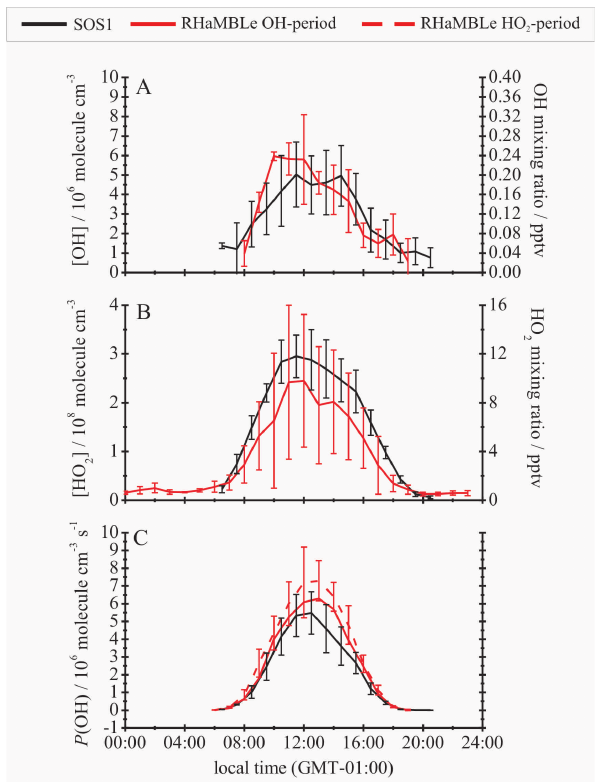
Fig. 9. Plots of the hourly-averaged median diurnal profiles of OH (A) , HO 2 (B) and P (OH) (C) for SOS2 (June 2009; black lines) and RHaMBLe (May–June 2007; solid red OH-measuring period, dashed red HO 2 -measuring period). The error bars represent the 1 σ day-to-day variability in the hourly-averaged data. For clarity, the error bars on P (OH) for the OH-measuring period are not